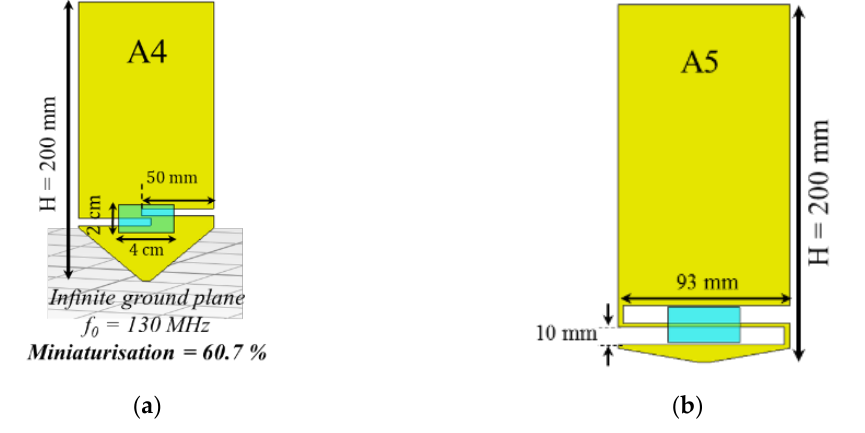
Figure 10. ( a ) Miniaturized monopole antenna A4 by the P-MDM of dimensions 4 × 2 cm with two slots of length 51.3 mm. ( b ) Miniaturized monopole antenna A5 by the P-MDM with two slots of dimensions 93 × 10 mm.